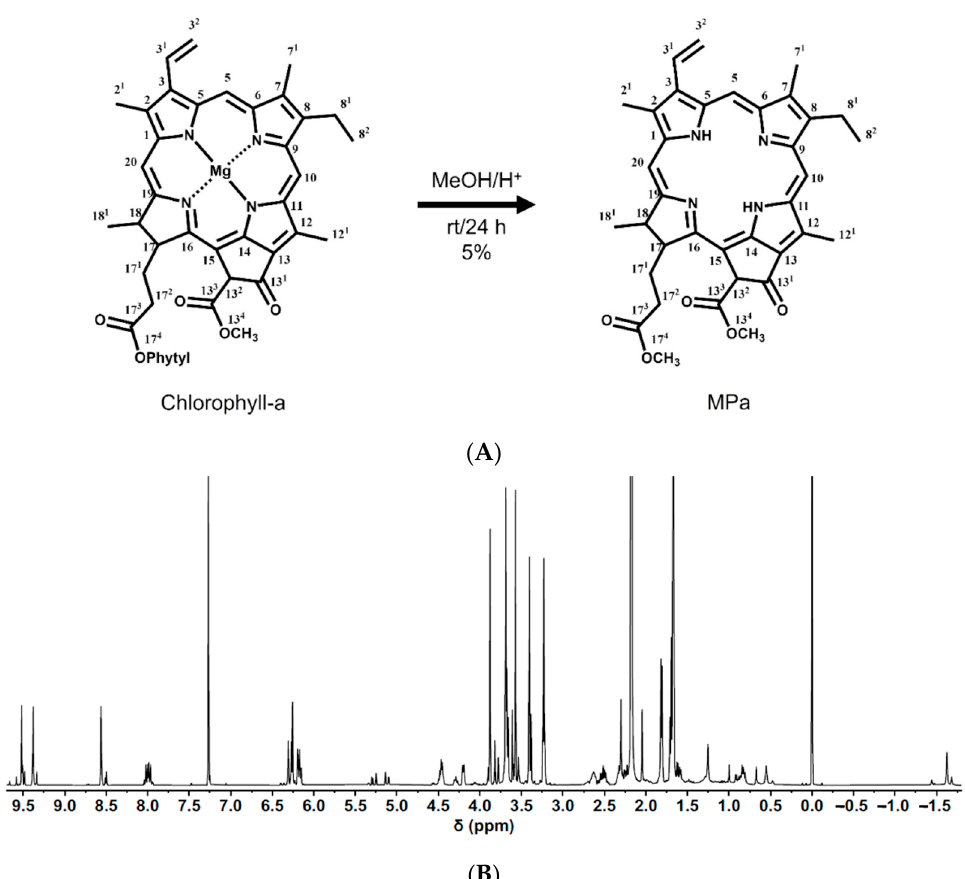
Figure 1. ( A ) Synthetic scheme of MPa from chlorophyll-a with numbering, ( B ) 1 H-NMR spectrum of MPa (500 MHz, CDCl 3 , 25 °C, TMS). of MPa (500 MHz, CDCl ◦ C, 3 , 25